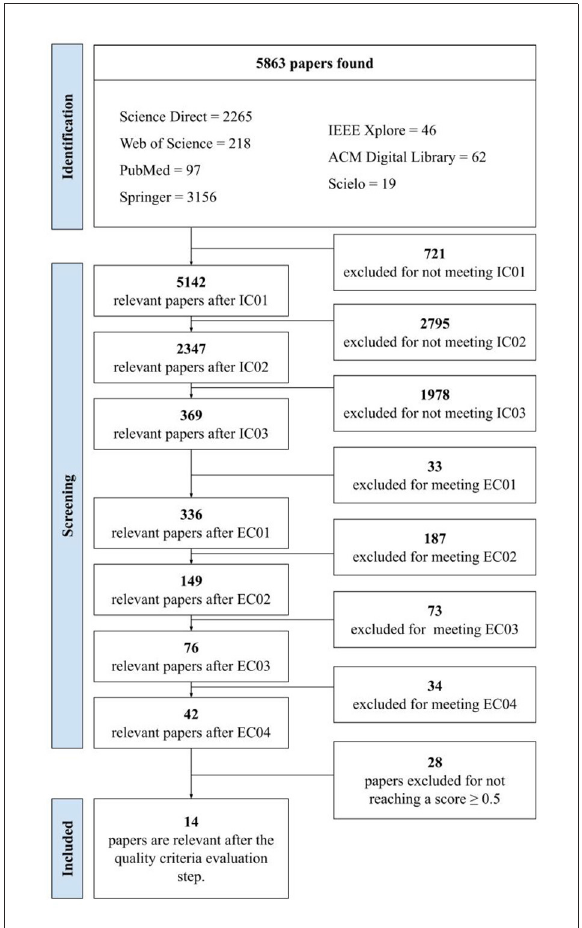
FIGURE1 Flowchart adapted from the PRISMA with result of the execution of the systematic review